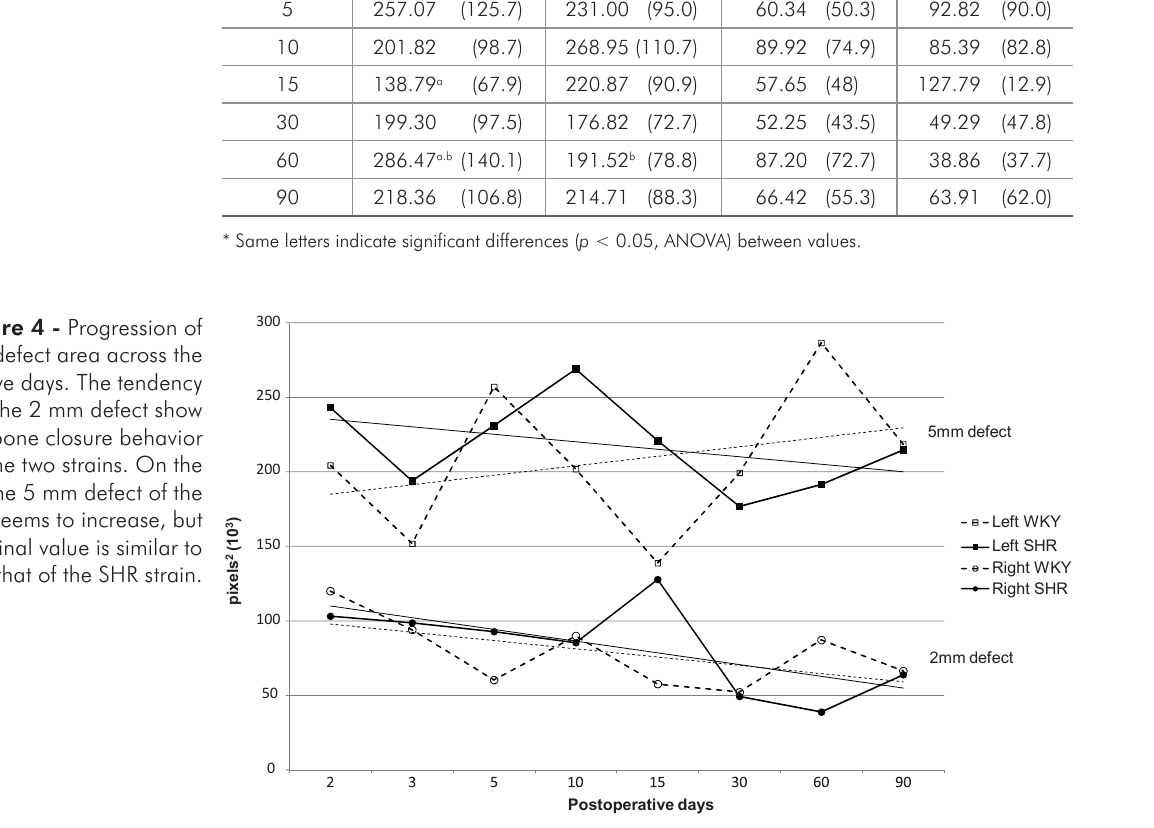
Table 1 - Defect area ( × 10 3 pixels 2 ) and percentage (%) in relation to the initial